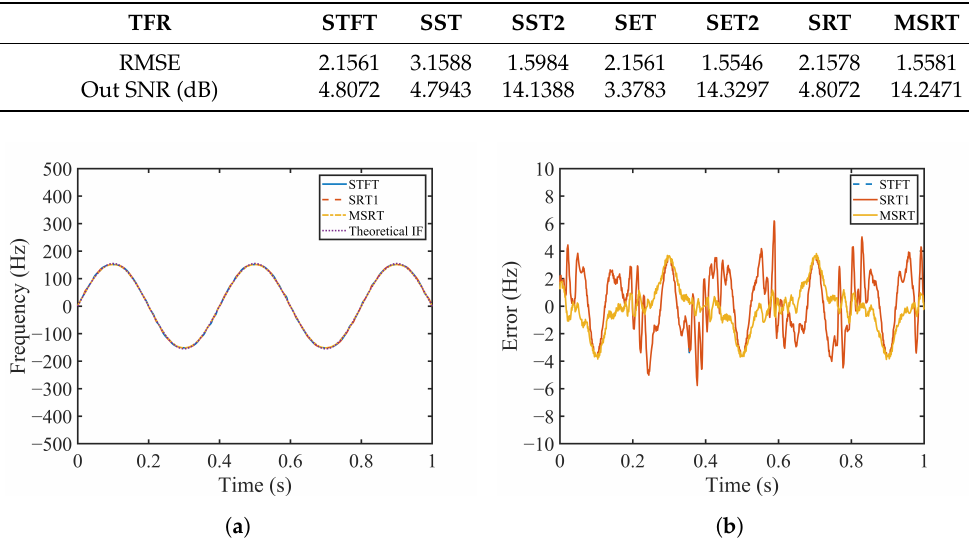
Table 4. RMSE between the estimated IF and the theoretical IF and the output SNR of the recon- structed signal.